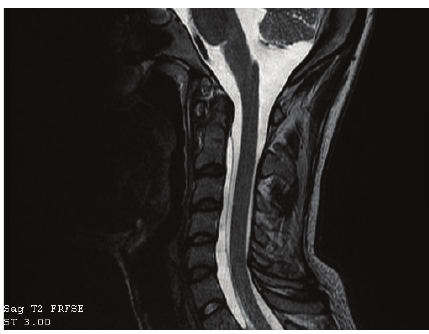
Figure 6: Sagittal MR reconstruction image shows an extradural meningeal spinal